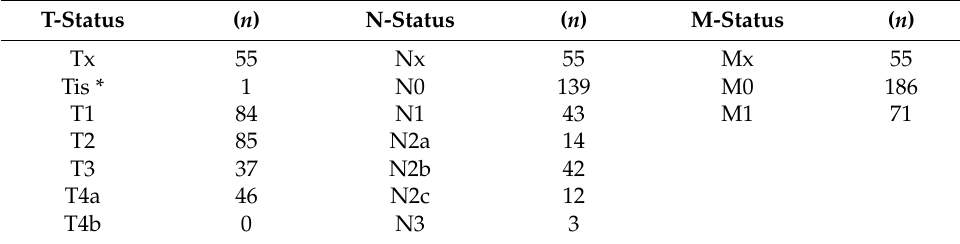
Table 2. Overview of the classification of the investigated OSCC in their TNM classification, regarding tumor extent, lymph node involvement and presence of distant